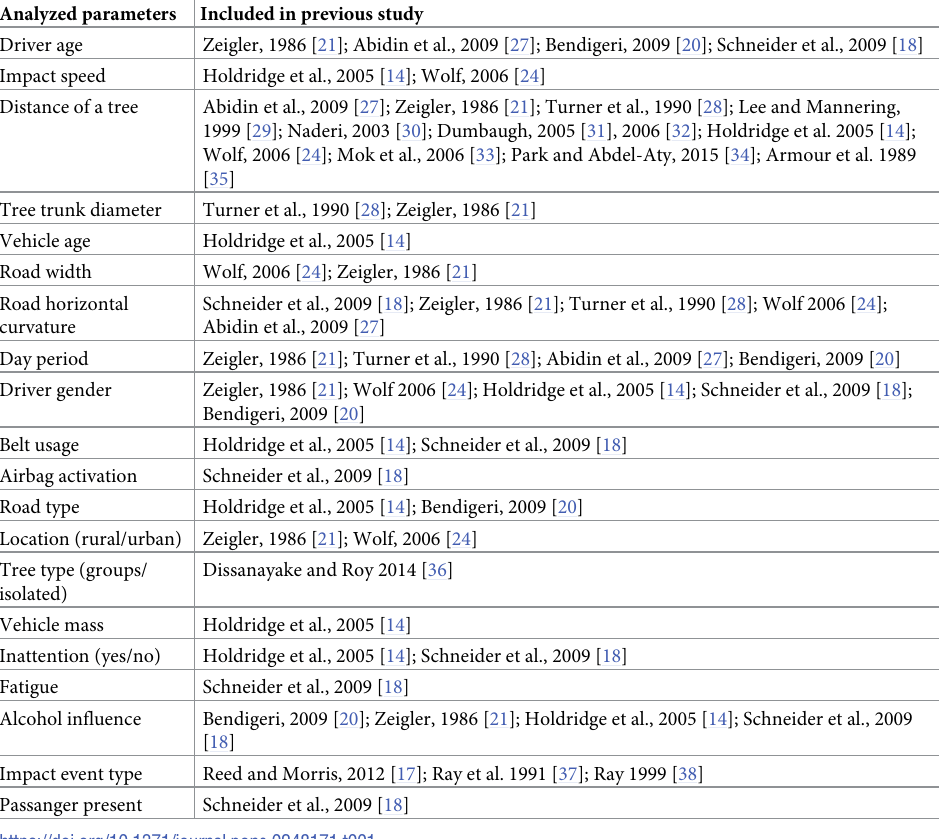
Table 1. Summary of selected research on tree crashes and impact of selected analyzed parameters on crash sever- ity and/or frequency. Analyzed parameters Included in previous